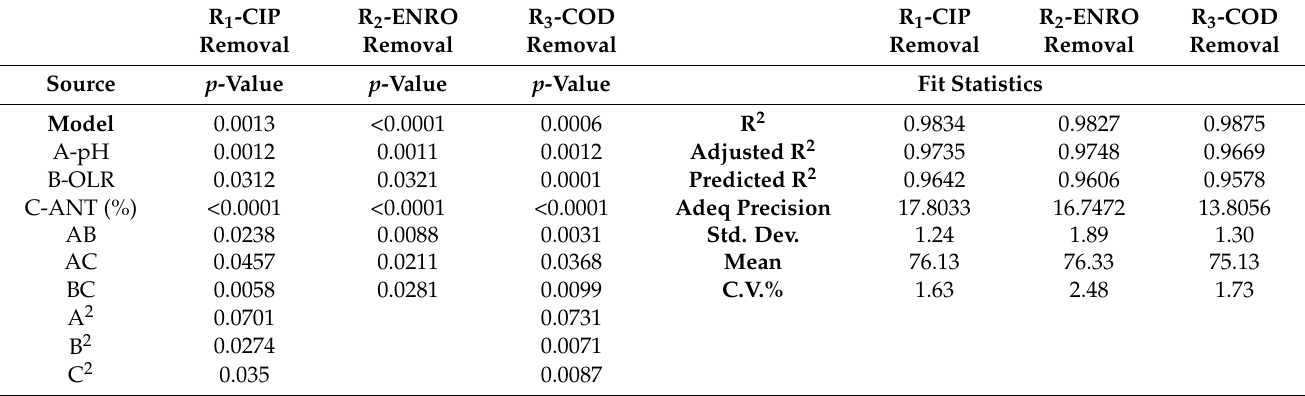
Table 4. Model fit statistics and regression